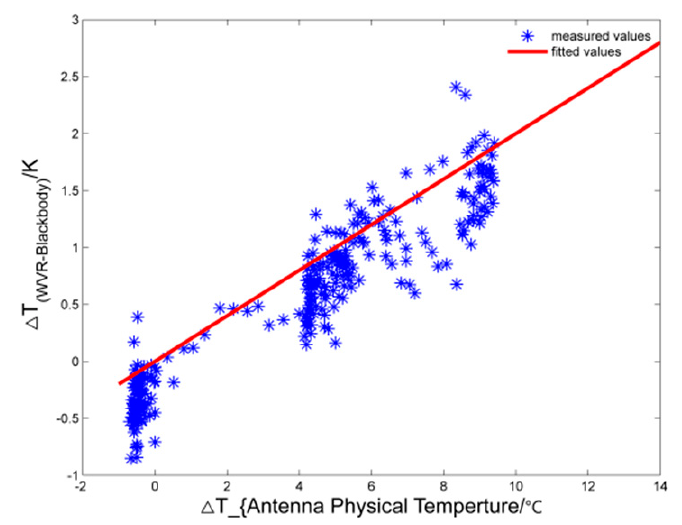
Figure 9. The relationship between the measured feed temperature and the difference between the measured WVR and the blackbody temperature.